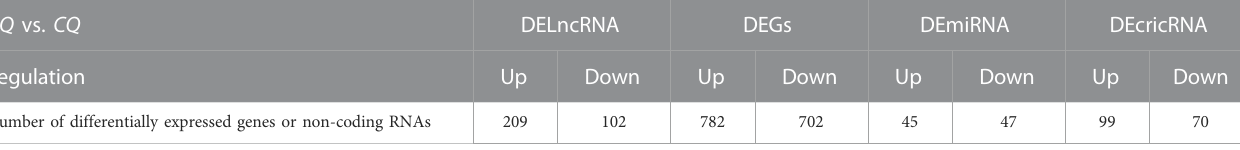
TABLE 2 Number of differentially expressed coding and non-coding RNAs identi fi ed from A. cerana arti fi cially nutritional cross queens vs. A. cerana natural queens. NQ vs. CQ Regulation Number of differentially expressed genes or non-coding